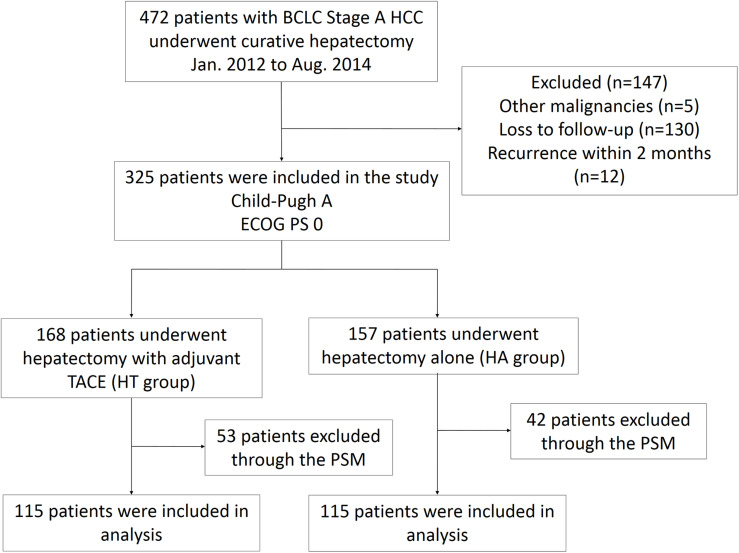
Flow diagram for extracting eligible cases for comparison. BCLC, Barcelona Clinic Liver Cancer; HCC, hepatocellular carcinoma; TACE, transarterial chemoembolization; PSM, propensity score matching; ECOG, Eastern Cooperative Oncology Group; PS, performance status.